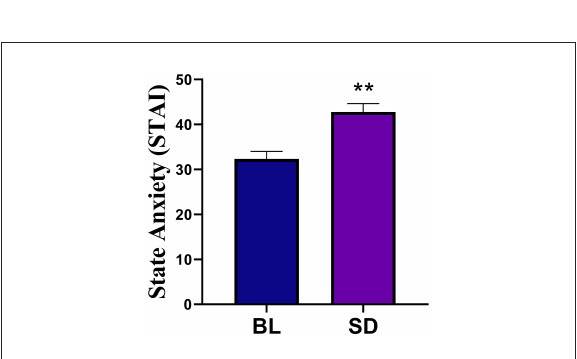
FIGURE4 Compared to baseline (BL) there was a significant increase in state anxiety following sleep deprivation. Errors bars represent SEM and double asterisks indicate p <